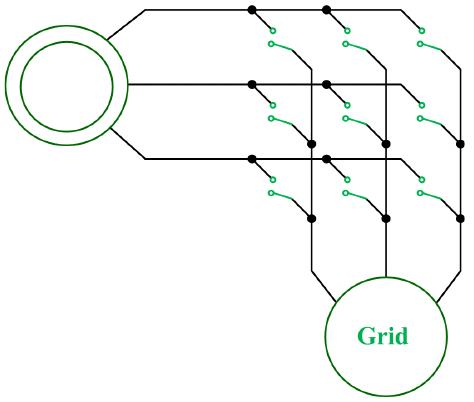
Figure 5. The matrix converter wind generation